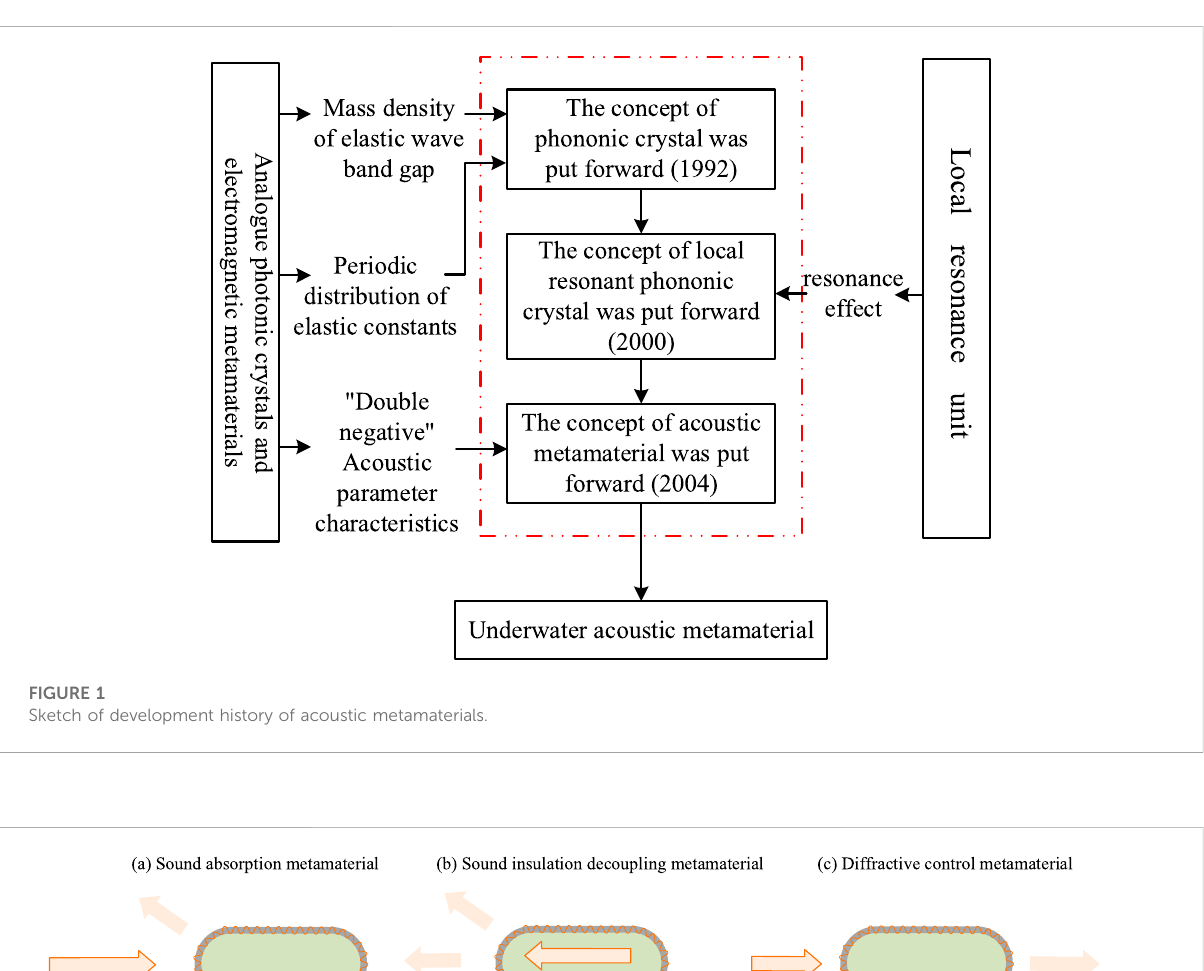
Schematic diagram of regulation function of three kinds of underwater acoustic